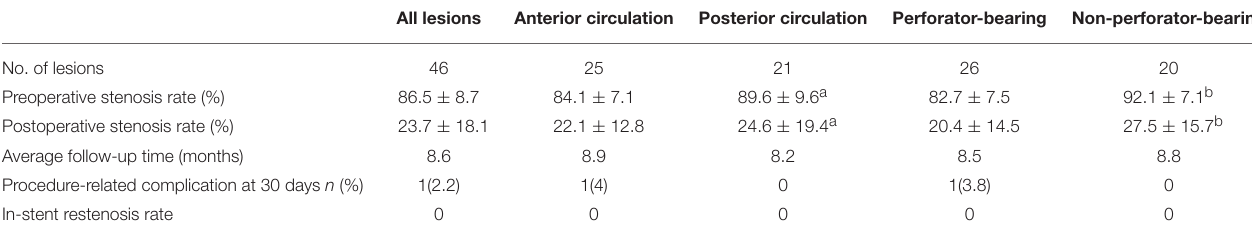
TABLE 2 | The clinical variables of the